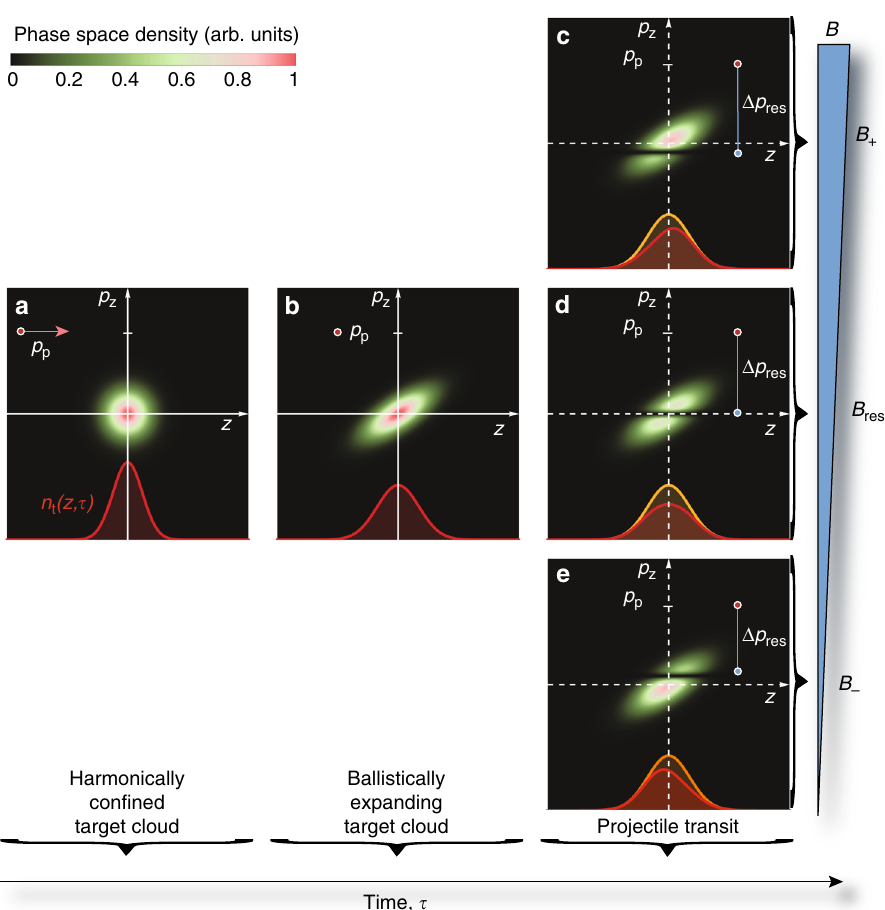
Fig. 3 Collision between a projectile test particle and a target cloud. Phase-space representations of an incident test particle with momentum p p ^ z moving in the phase-space diagram and colliding with a stationary target cloud. a Harmonically trapped target cloud and an incident test particle of momentum p p as indicated by the arrow . b Target cloud after some time of ballistic expansion. c – e On transit, the test particle can only remove atoms from within a horizontal strip in the phase-space distribution of the target cloud centered at p t = p p − Δ p res ( B ). Depending on the value of B the strip may be below ( c ), on ( d ), or above the z- axis ( e ). In all panels a – e the marginal spatial density distributions n t ( z , τ ) of the target cloud are shown at the bottom ( red line ). Panels c – e also shows n t ( z , τ ) just before the collision ( orange line